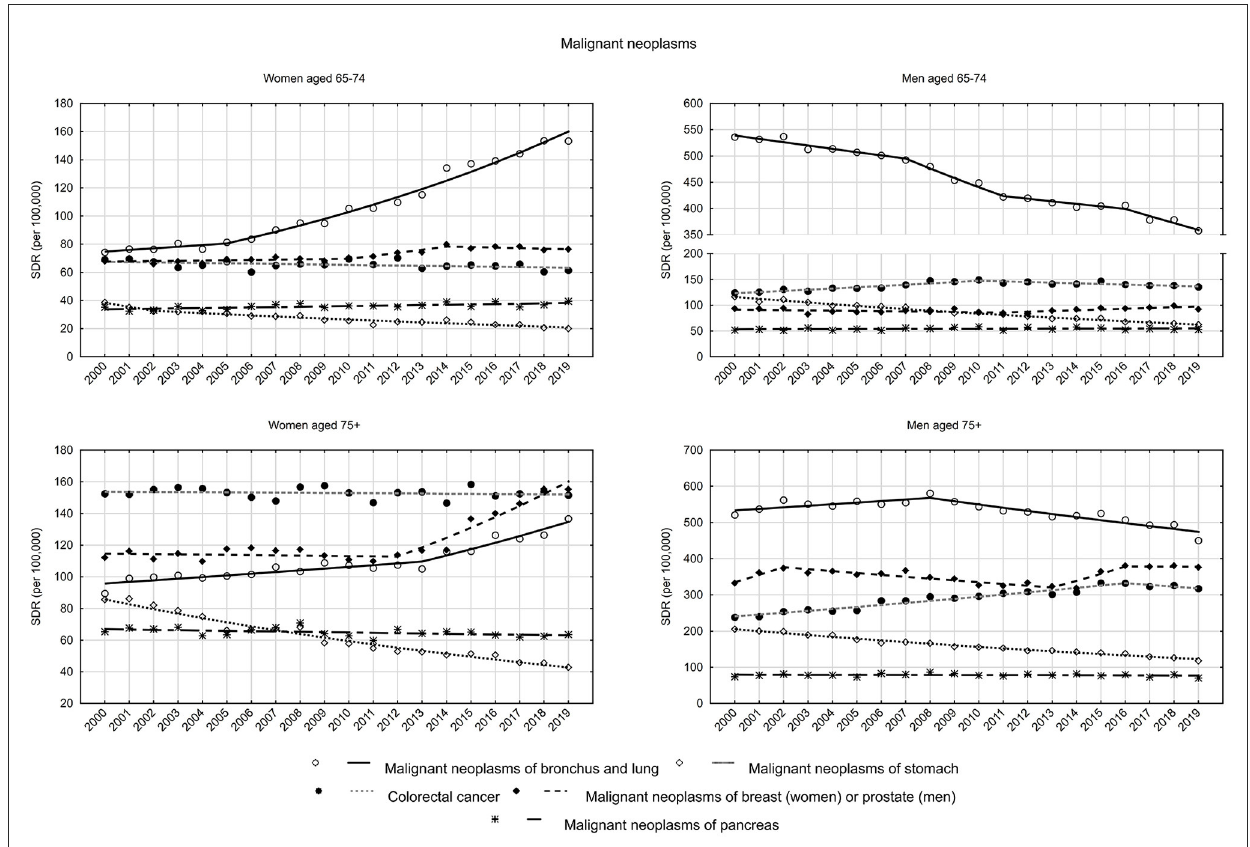
FIGURE3 SDR trends in the Polish population aged 65–74 years and 75 years and older due to malignant neoplasms in the years 2000–2019.